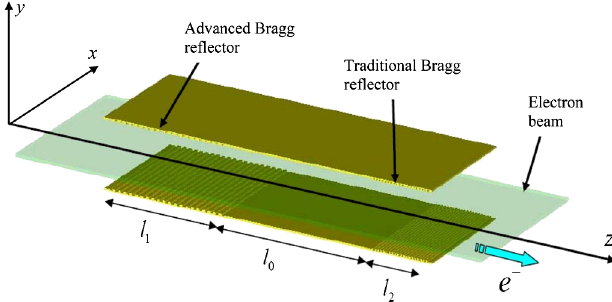
FIG. 1. (Color) Scheme of a planar FEL with hybrid Bragg resonator: 1—advanced Bragg reflector; 2—traditional Bragg reflectors; 3—electron